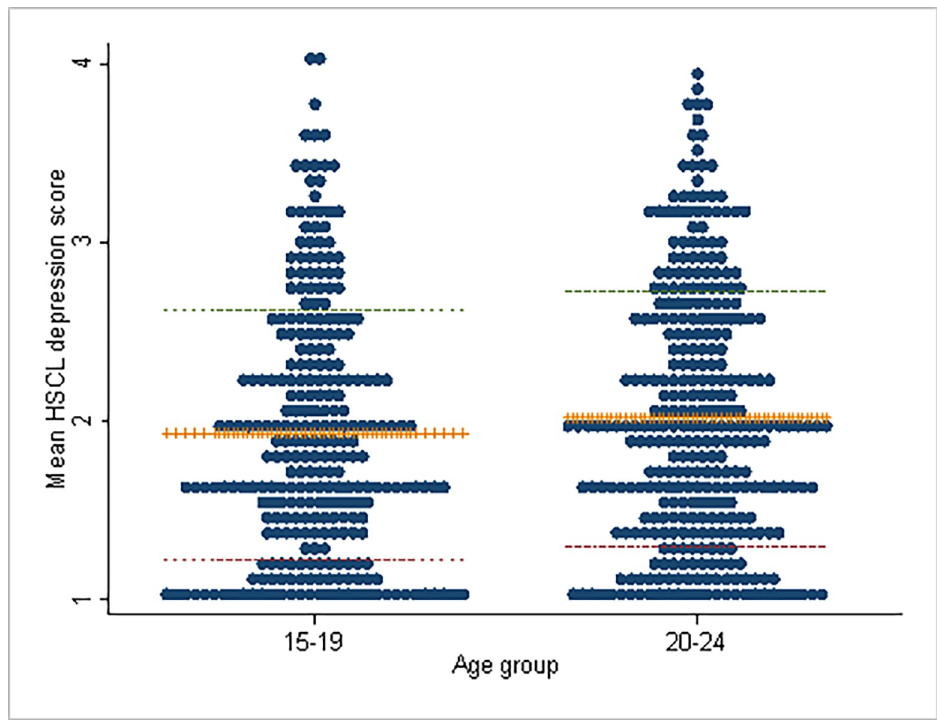
Fig 2. Distribution of mean HSCL depression score by age group. +++++ Represents average HSCL depression score.